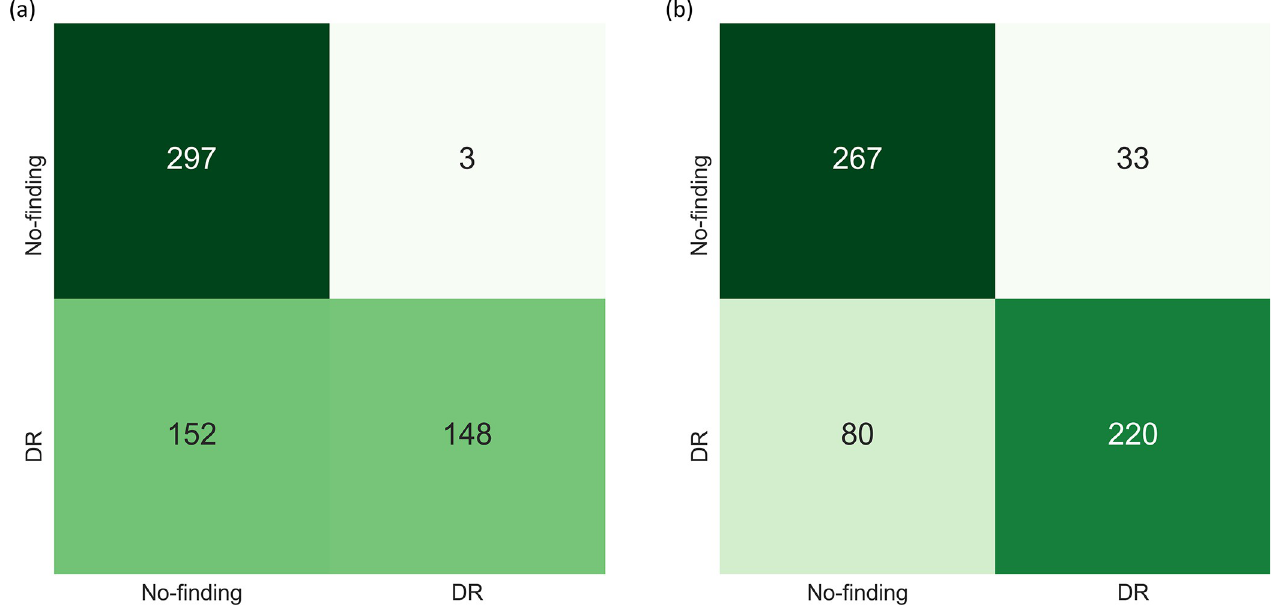
Fig 6. Confusion matrices obtained using the uncalibrated and calibrated probabilities (from left to right) at the baseline threshold of 0.5 for the Set-20 dataset constructed from the APTOS’19 fundus dataset. https://doi.org/10.1371/journal.pone.0262838.g006 Figs 6 and 7 show the confusion matrices obtained using the uncalibrated and calibrated prob- abilities, at the default classification threshold of 0.5, for the Set-20 dataset, individually con- structed from the APTOS’19 fundus and Shenzhen TB CXR datasets. S4 and S5 Figs show the confusion matrices obtained for other class-imbalance simulated datasets.